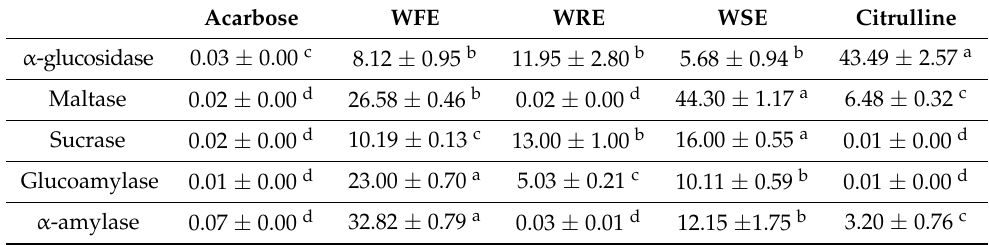
Table 2. The IC 50 values of watermelon extracts on carbohydrate-hydrolyzing enzymes